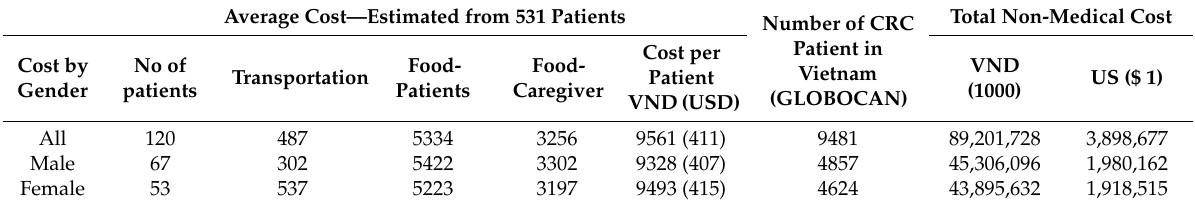
Table 2. Average Non-Medical Cost of Colorectal Cancer per Patient and Estimated Total Non-Medical Cost at National Level in Vietnam, 2018 (1000 VND).